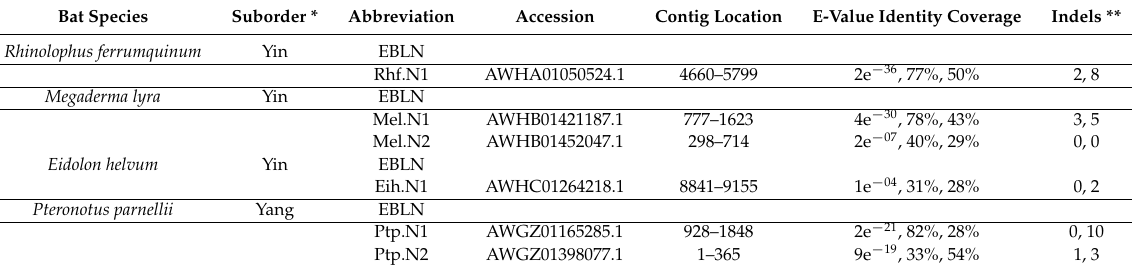
Table 1. Distribution of bornaviral elements in bat